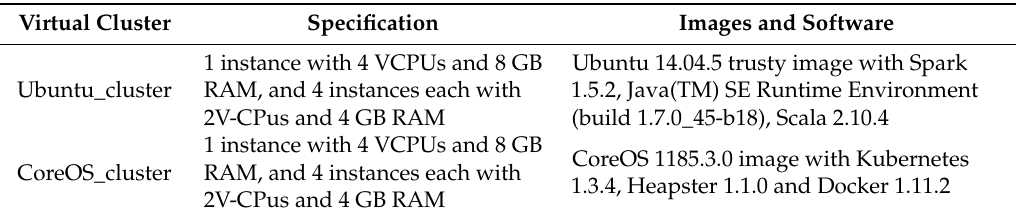
Table 2. Two comparable clusters in the OpenStack